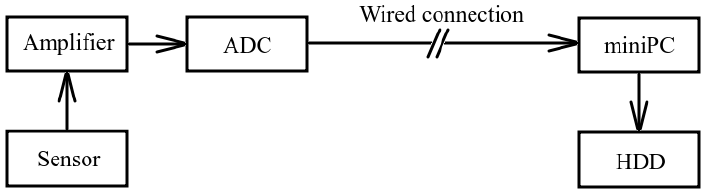
Figure 4. Block scheme of the acoustic receiving system with wired